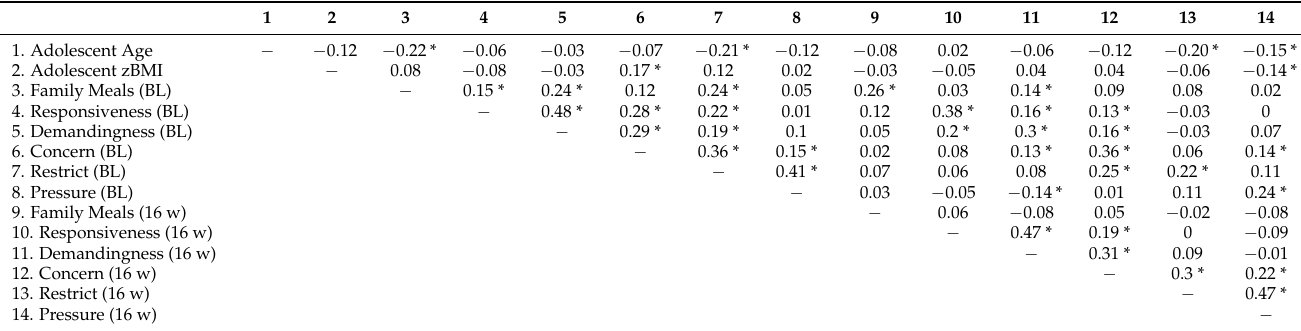
Table 2. Bivariate correlations between predictors and family